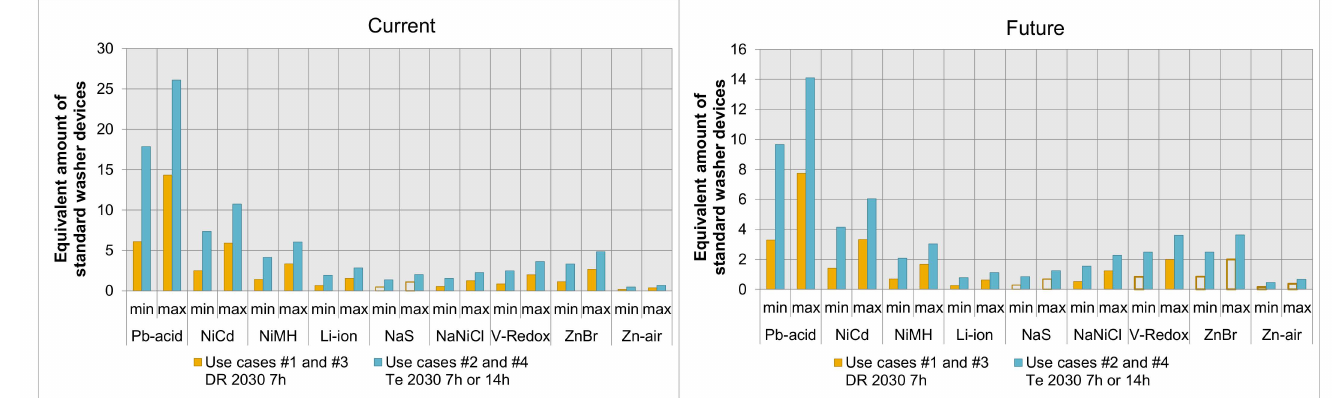
Figure 9. Gravimetric analogy illustrating the number of standard washer devices required in all case